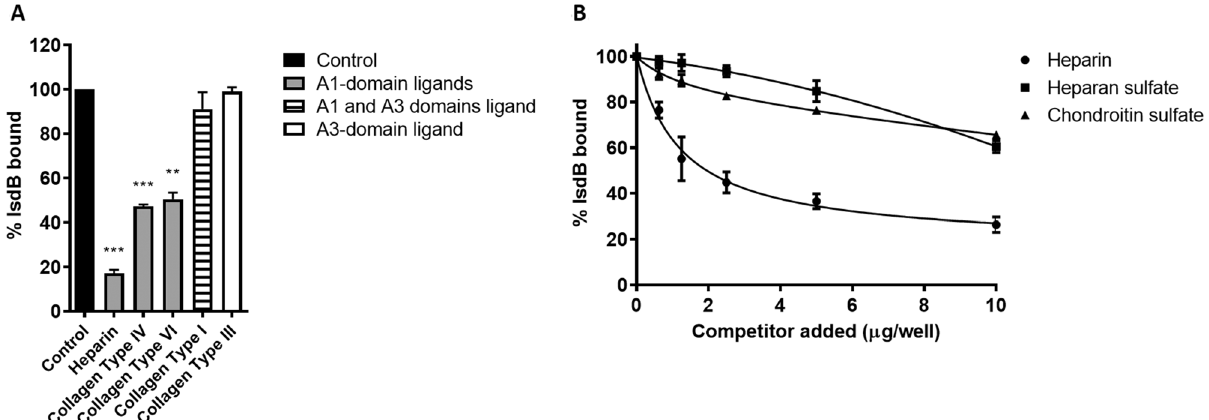
Figure 4. Interference of vWF ligands with the VWF/IsdB interaction. (A) the effect of vWF ligands on the binding of IsdB NEAT1–NEAT2 to immobilized vWF. Microtiter wells coated with vWF were incubated with IsdB NEAT1–NEAT2 in the presence of the indicated potential competitors. IsdB NEAT1-NEAT2 binding to the wells was detected by the addition of a polyclonal rabbit anti-IsdB IgG followed by HRP-conjugated goat anti-rabbit IgG. Binding data are expressed as a percentage of the control, i.e. incubation performed in the absence of any potential IsdB competitor. Statistically significant differences are indicated (**, P < 0.01, ***, P < 0.001). (B) The effect of polyanionic compounds on the binding of IsdB NEAT1–NEAT2 to immobilized vWF. Microtiter wells coated with vWF were incubated with IsdB NEAT1–NEAT2 in the presence of increasing concentrations of heparin, heparan sulfate, and chondroitin sulfate. Binding was detected as reported in (A) . The data points are the means ± SD from three independent experiments, each performed in